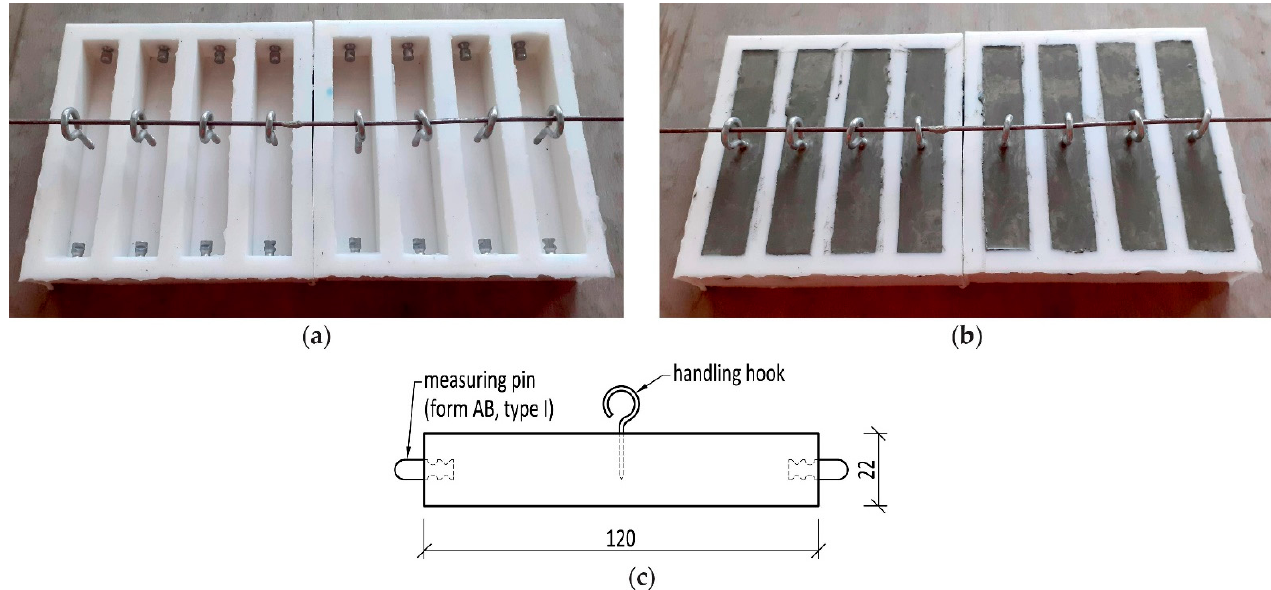
Figure 6. ( a ) Molds prepared for the production of the test specimens; ( b ) molds filled with a model mortar; ( c ) a schematic of a test specimen with fittings.